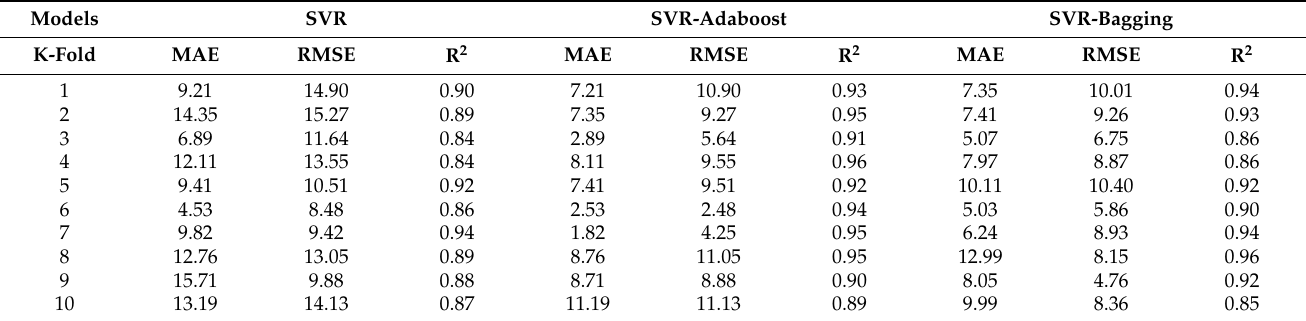
Table 6. Cross-validation results of the RFR model with statistical measures. Model